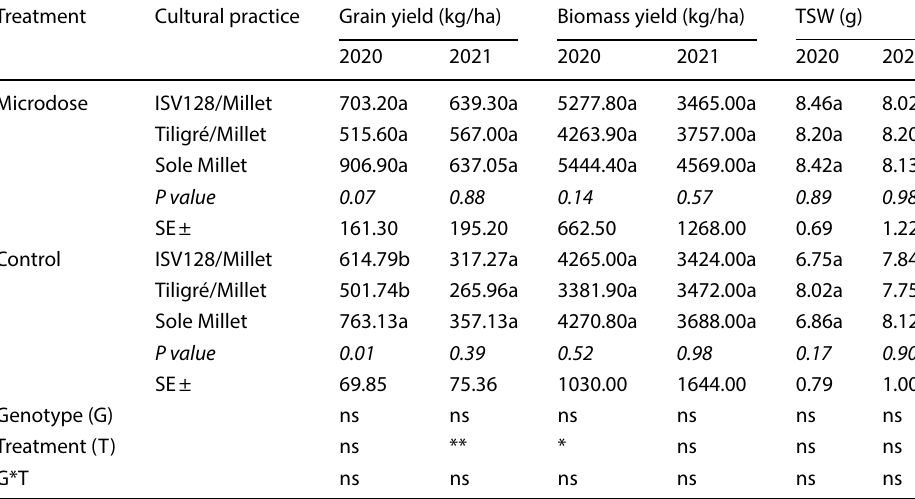
Table 3 Effect of intercrop and microdose on millet yields